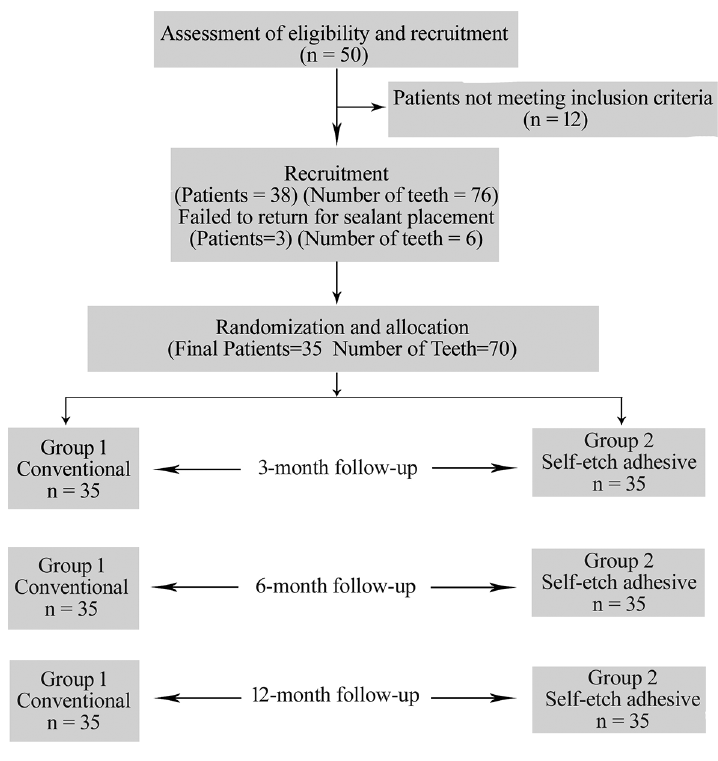
Figure 1. CONSORT flow